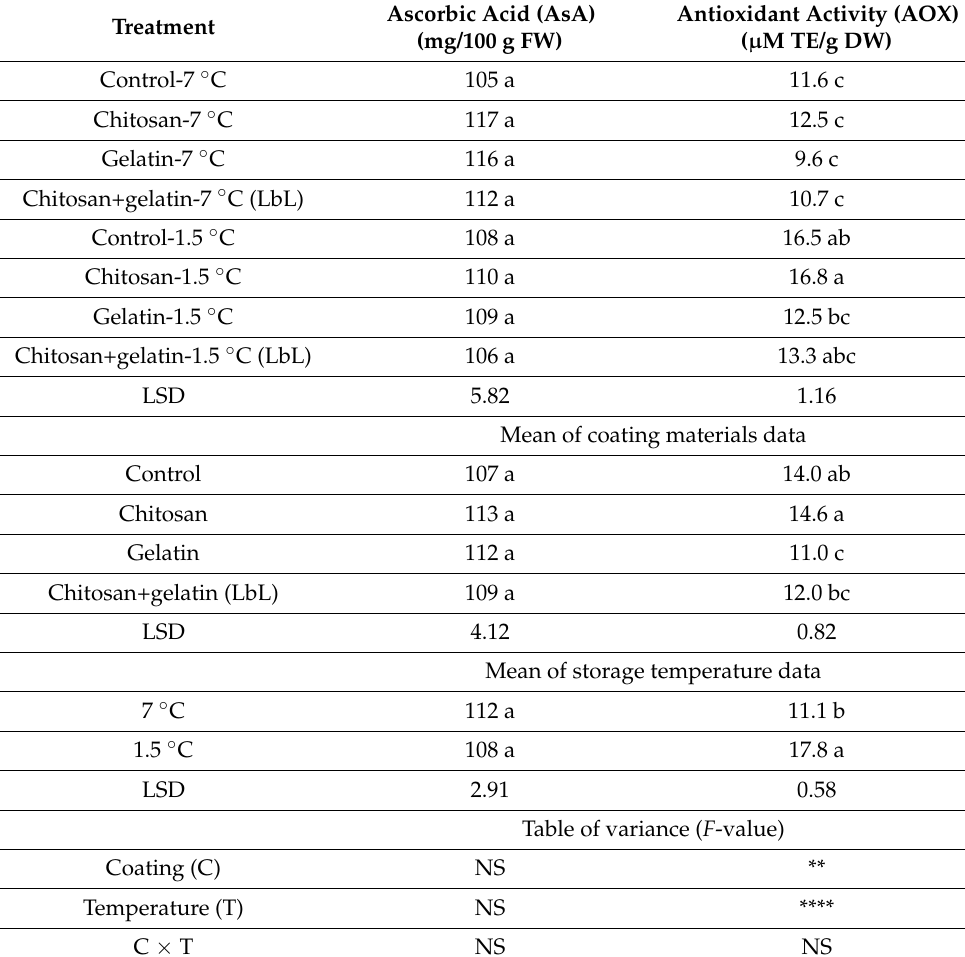
Table 3. The effects of different coatings and storage temperatures on red pepper fruit quality, in terms of ascorbic acid (AsA) content (mg/100 g FW) and total antioxidant activity ( µ M TE) after 21 d at 7 ◦ C or 1.5 ◦ C, followed by 3 d at 21 ◦ C. Mean data from three harvests are presented; each harvest consisted of two boxes with 20 fruit in each box.